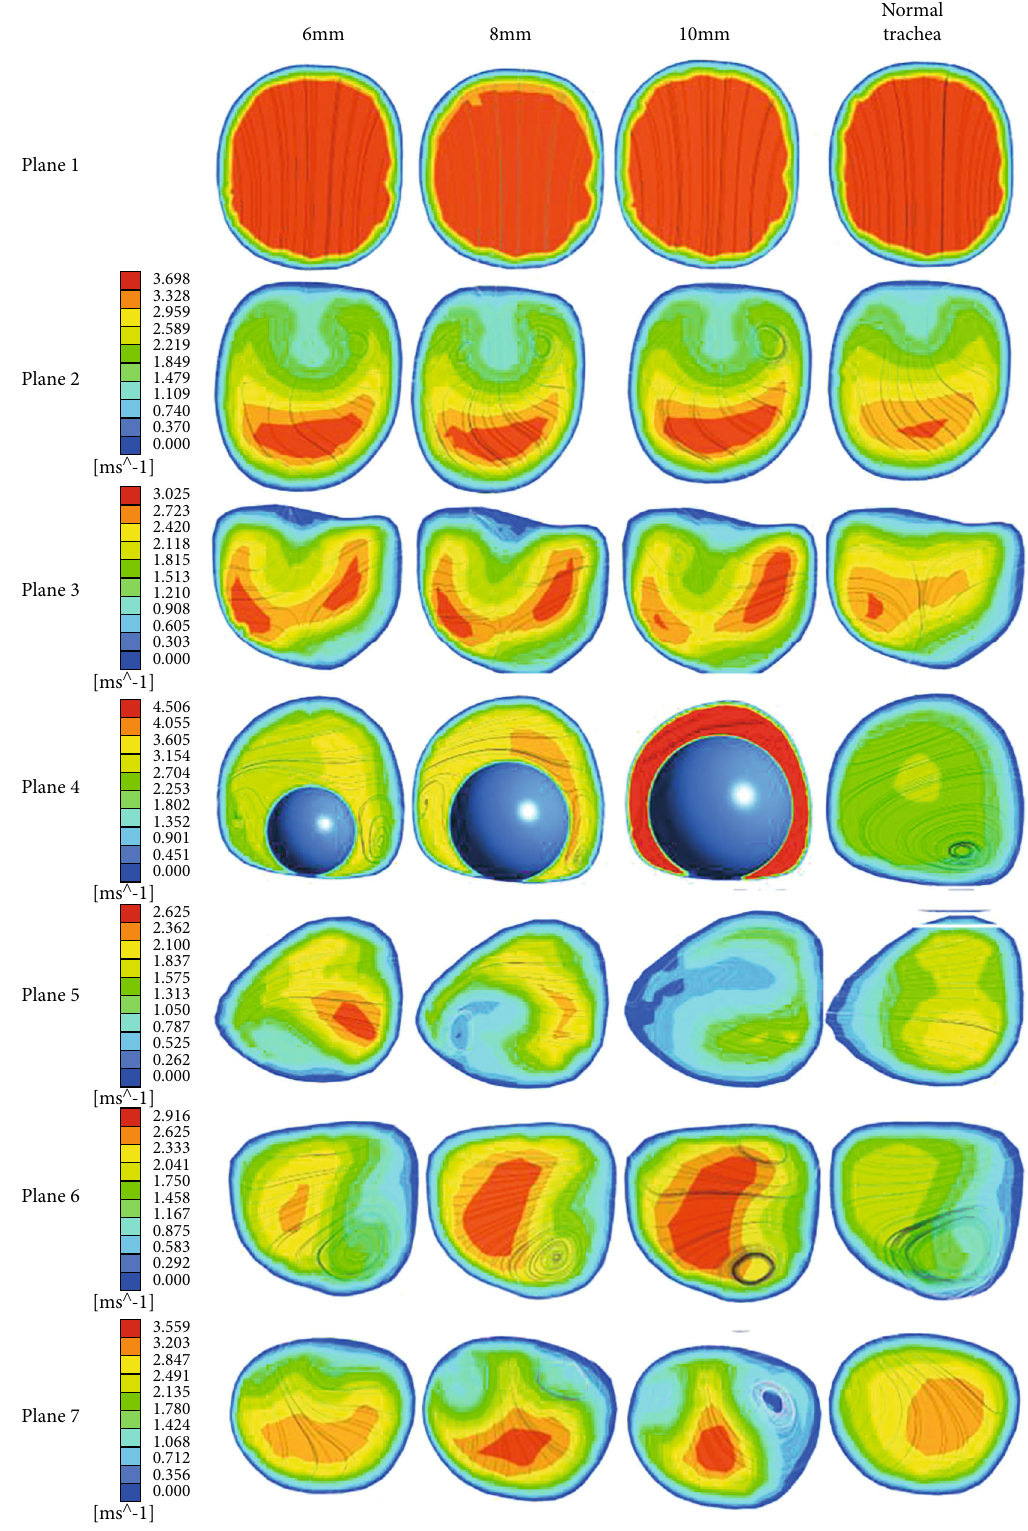
Figure 6: Velocity contours at di ff erent positions of the healthy airways and airways with di ff erent